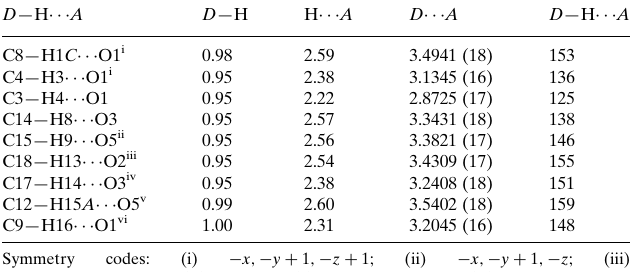
Hydrogen-bond geometry (A˚ , (cid:2)